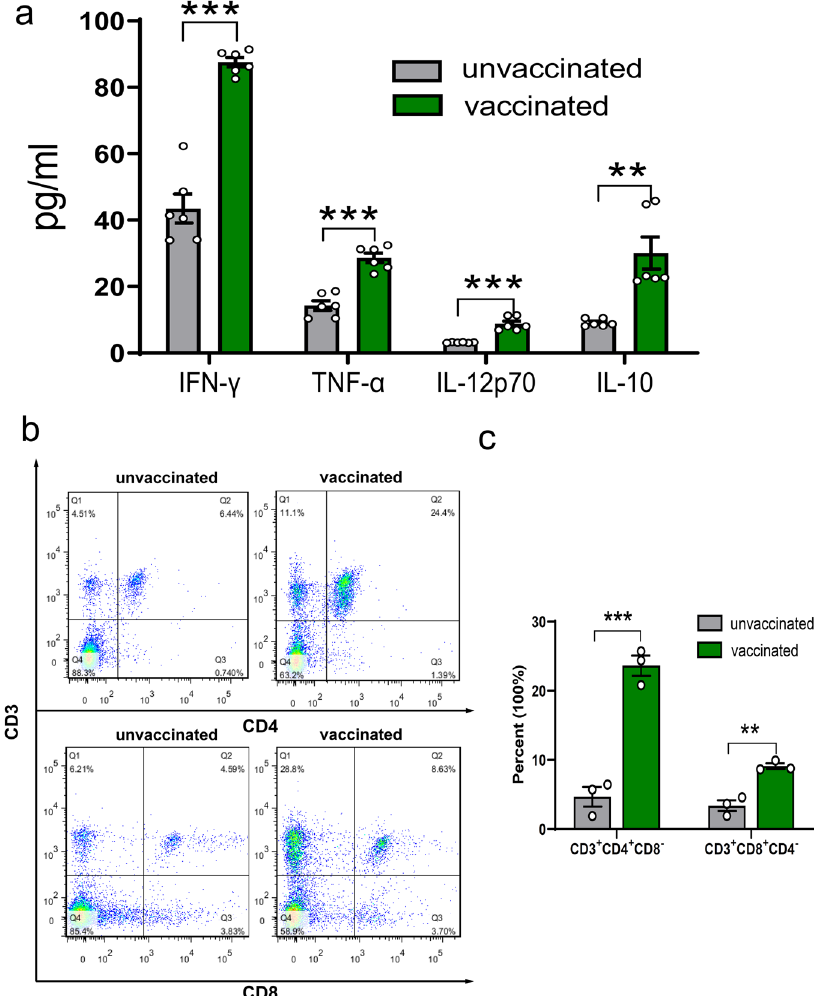
Fig. 6 ME49 Δ cdpk3 vaccination induced cellular immune response after Toxoplasma antigen stimulation. a Spleen cells were harvested 75 days after ME49 Δ cdpk3 vaccination and stimulated in vitro with 10 µg/mL soluble ME49 antigen. IFN- γ , TNF- α , IL-12p70 and IL-10 levels in splenocyte culture supernatants were subsequently tested by ELISA (n = 6 each group). The statistical analysis was performed by using unpaired t test. Bars = mean ± SEM. Statistical differences are represented by *** p < 0.001, ** p < 0.01. b The percentages of CD3 + CD8 + T lymphocytes and CD3 + CD4 + T lymphocytes in mice spleen cells was detected by fl ow cytometry. Splenocytes from non-immunized mice were used as negative controls. c Quantitative data of ( b ) are expressed as the mean ± SEM ( n = 3). The statistical analysis was performed by using unpaired t test. Statistical differences are represented by *** p < 0.001, ** p <